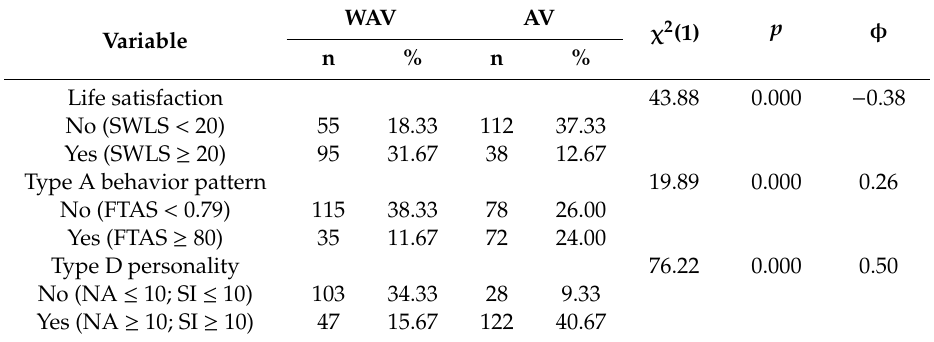
Table 3. The prevalence of satisfaction with life, TABP, and Type D personality in samples of young women with (AV) and without (WAV) acne